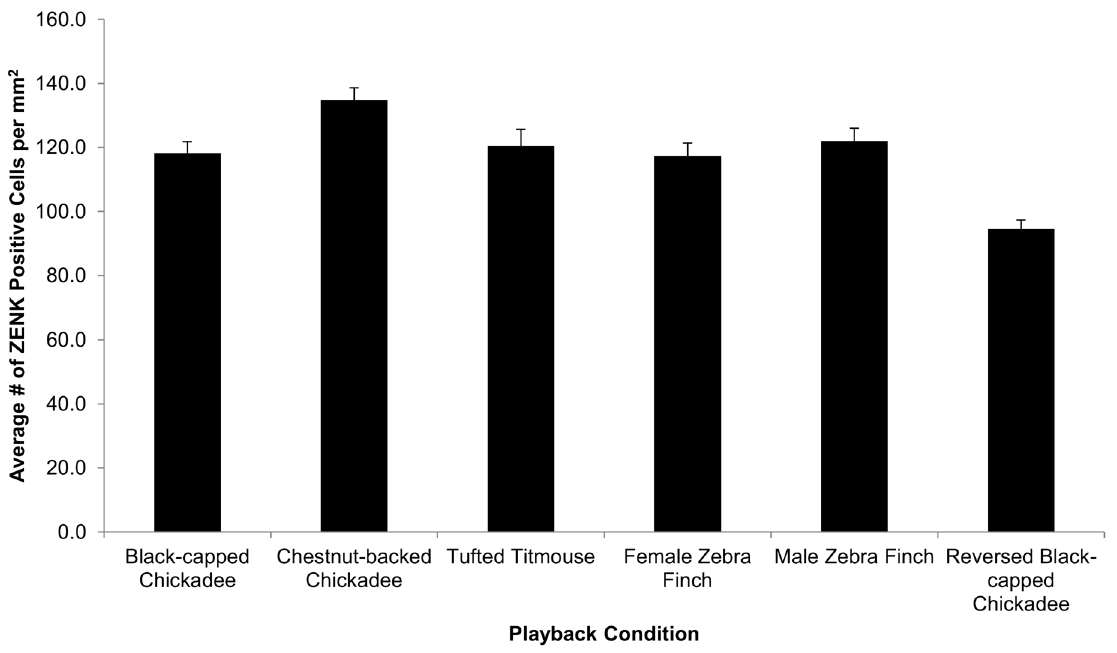
Figure 3. ZENK expression by playback condition. Playback condition was significant p , 0.01, and post hoc comparisons (Tukey HSD) indicated no significant differences in mean ZENK expression between any of the playback conditions except for the reversed black-capped chickadee condition had less ZENK expression compared to all other playback conditions (black-capped chickadee, p =0.04; chestnut-backed chickadee, p , 0.01; tufted titmouse, p =0.03; female zebra finch, p =0.05; male zebra finch, p =0.01). Y = mean over subjects 6 SEM and X = Playback Condition.